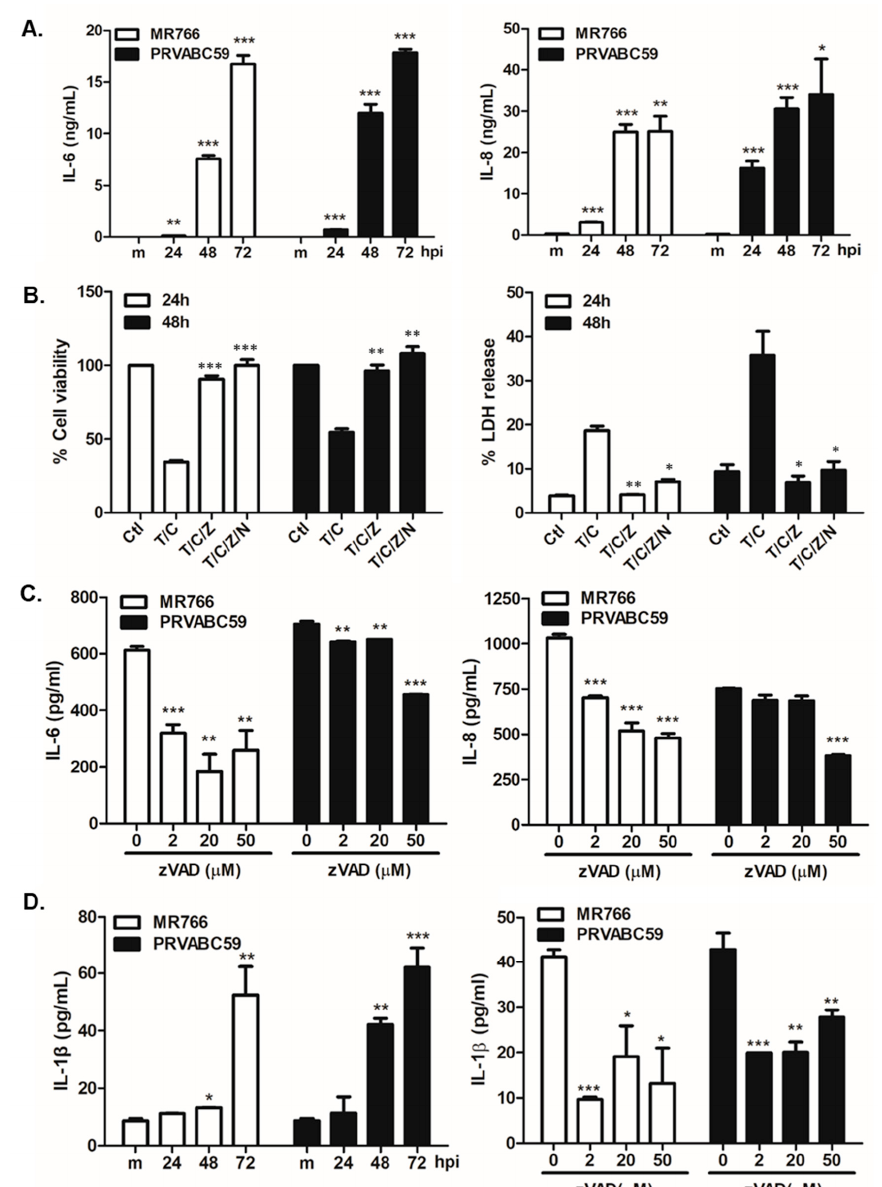
Figure 3. The effect of apoptosis inhibitors on inflammation during Zika virus (ZIKV) infection of hNPCs. ( A ) hNPCs were infected with ZIKV at MOI of 3. IL-6 and IL-8 secretion levels at 24, 48, and 72 hpi were measured by ELISA. ( B ) hNPCs were treated with TNF- α and cycloheximide (T/C), TNF- α , cycloheximide, and zVAD-fmk (T/C/Z), or TNF- α , cycloheximide, z-VAD-fmk, and Nec-1 (T/C/Z/N). % cell survival was determined by the CellTiter-Glo assay ( left ). % LDH release was measured in cell supernatants and the graph represents the mean and standard deviation of three independent experiments ( right ). * p < 0.05; ** p < 0.01; *** p < 0.001, compared to T/C-treated cells. ( C ) hNPCs were treated with 0, 2, 20, and 50 μ M of z-VAD-fmk overnight and infected with ZIKV for 24 hpi. IL-6 and IL-8 secretion levels were determined by ELISA. * p < 0.05; ** p < 0.01; *** p < 0.001, compared to DMSO control-treated cells. ( D ) IL-1 β secretion level was measured at 24, 48, and 72 hpi by ELISA ( left ). hNPCs were treated with 0, 2, 20, and 50 µ M of z-VAD-fmk overnight and infected with ZIKV for 48 hpi. IL-1 β secretion levels were determined by ELISA ( right ). * p < 0.05; ** p < 0.01; *** p < 0.001, compared to DMSO control-treated